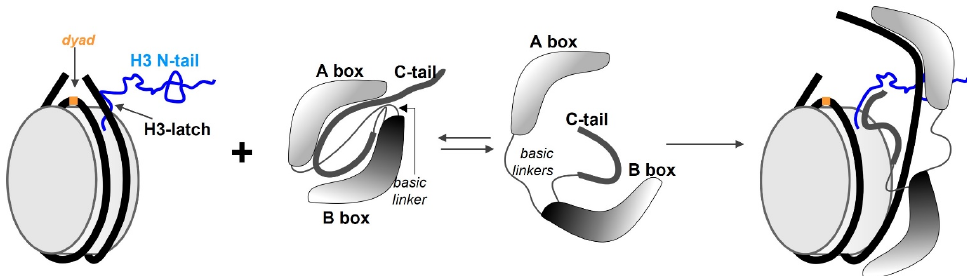
Figure 3. The interaction of HMGB1 with the NCP. Schematic representation of nucleosomal DNA (black), a histone octamer (a grey cylinder), HMGB1 (A and B boxes, two basic linkers and the acidic C-tail) and the basic N-tail of H3. The dyad is highlighted in orange. In the absence of DNA, HMGB1 is in a closed conformation that is transformed by non-sequence-specific interaction with linker DNA at the entry/exit site of NCP. The complex is stabilised by the interaction between the acidic tail of HMGB1 and N- tail of H3; the interaction drives DNA unwrapping and NCP destabilisation.